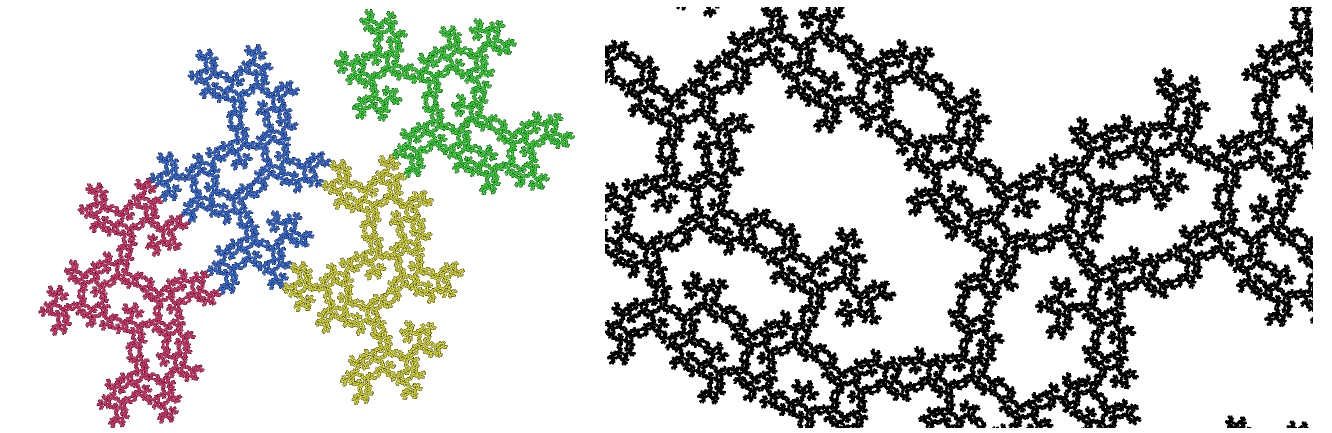
Figure 2. A carpet generated from an irrational rotation and a reflection. It has 13 neighbor types and no characteristic directions. For details, see Section